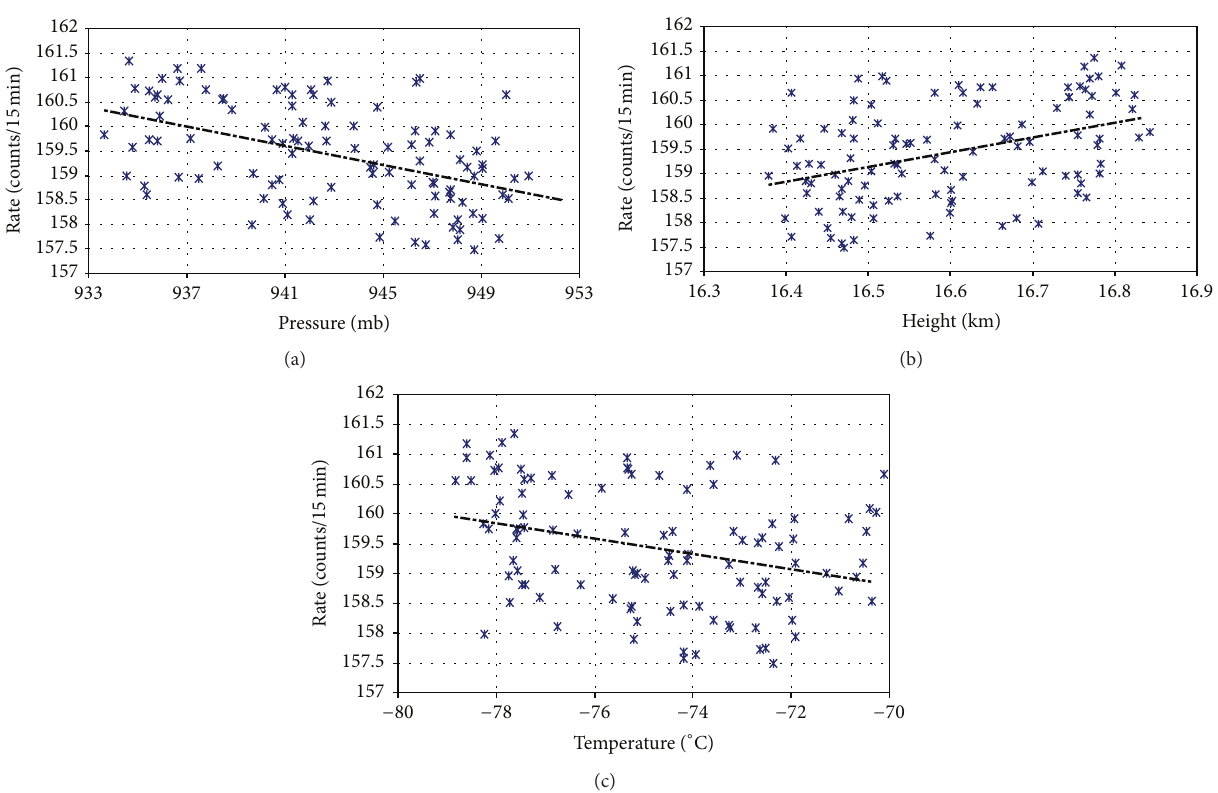
Figure 3: Scatterplot between the muon mean monthly values against (a) pressure, (b) height, and (c) temperature. The dashed thick lines are the regression lines.